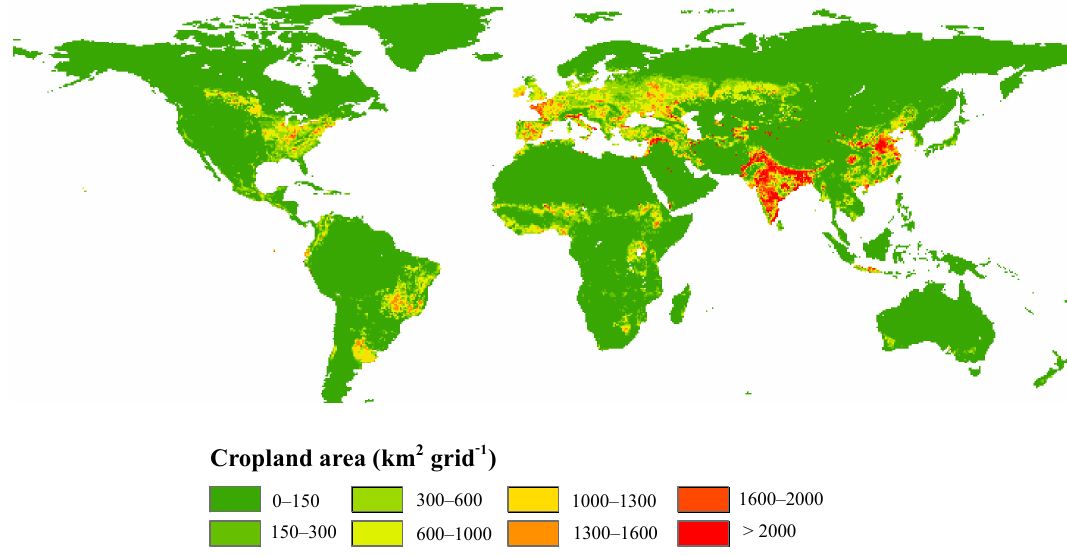
Figure 2. The spatial distribution of cropland area in